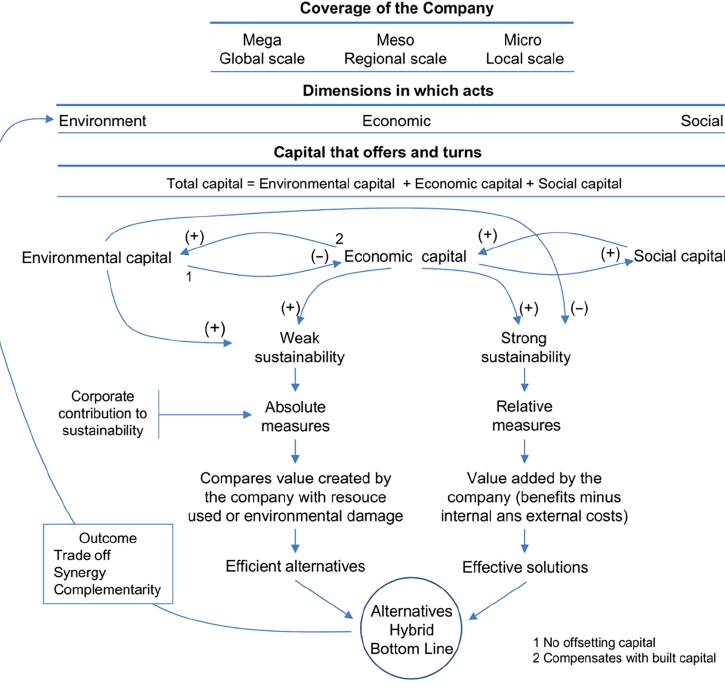
Fig. 1. Cycle of interactive